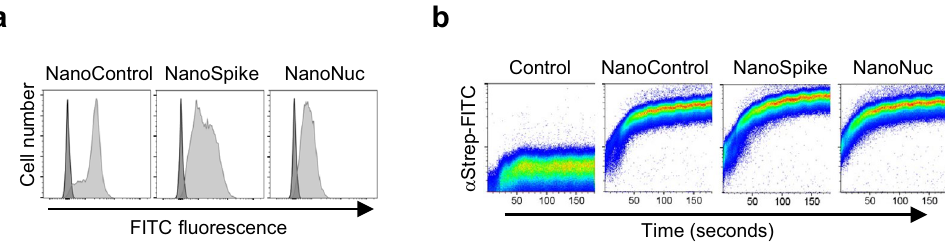
Figure 2. RBC-directed recombinant proteins bind RBC swiftly and quantitatively. ( a ) Flow cytometry analysis of human RBC that were left untreated (dark) or incubated with 30 µg/ml indicated proteins (light), followed by incubation with FITC-labeled AB against the Strep-tag. ( b ) Kinetics of RBC-binding of nanobody-fusion proteins analyzed by flow cytometry. αStrep-FITC AB alone (control) or together with indicated recombinant proteins was added to human RBC (time point 0) and binding was analyzed by flow cytometry during